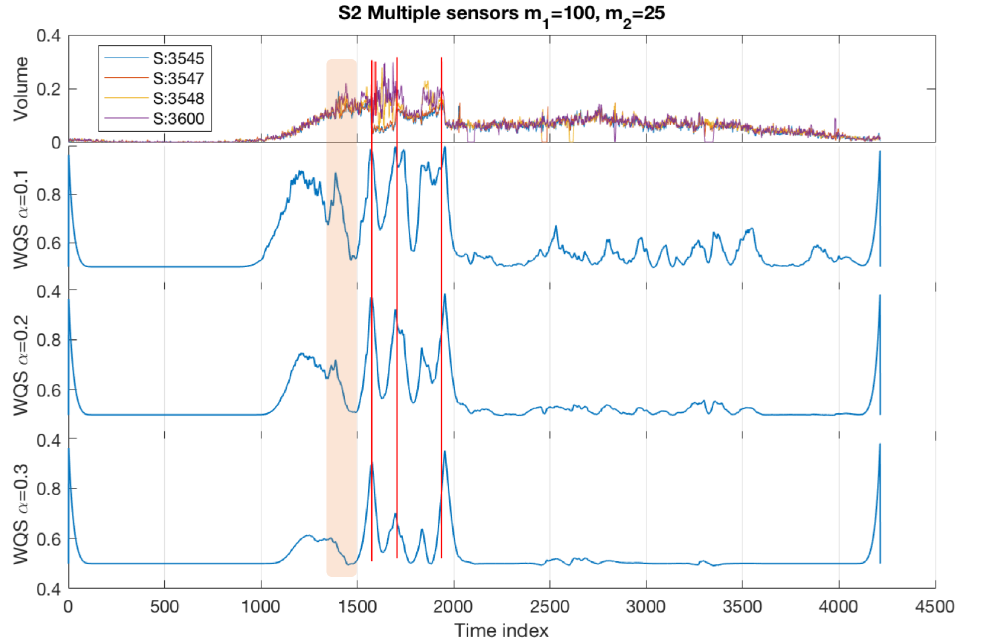
Figure 6. Incident S2 multiple sensor results with weighting parameters m 1 = 100, m 2 = 25 over different recurrence plot threshold scales α = 0.1,0.2, 0.3. The vertical red lines refer to the incident start time, incident end time and queue end time respectively (see Table 1). The shaded area highlights an incident with a lower impact level on the traffic flow than the major incident S2—this was only detected by the smaller value of α